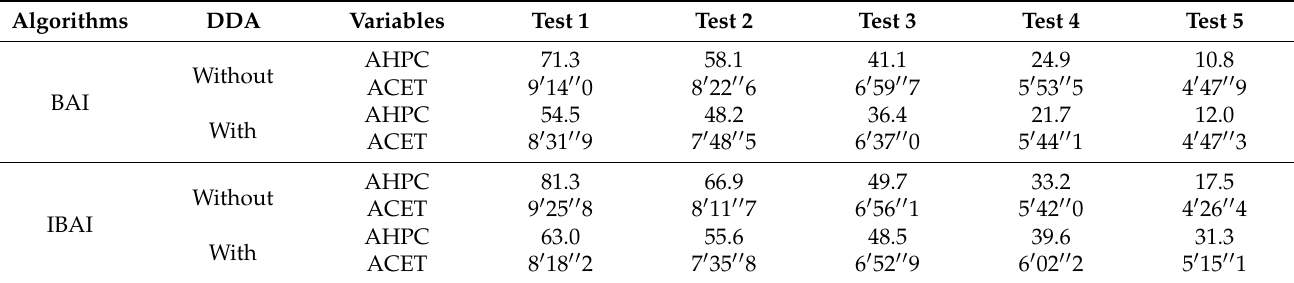
Table 6. DDA effectiveness parameters of BAI and IBAI.